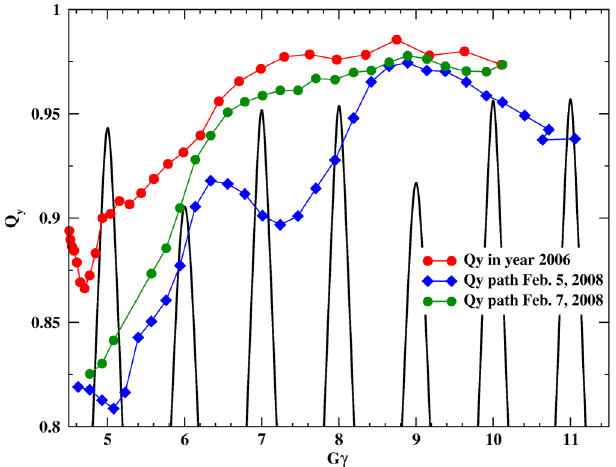
FIG. 12. The spin tune and the experimentally measured frac- tional part of the vertical betatron tune for various polarization runs plotted as a function of G(cid:3) at near injection energies. Note that in these polarization runs, the fractional vertical betatron tune is near or crosses the spin tune line. This indicates the nonelimination of the vertical spin intrinsic resonances at near injection energies.